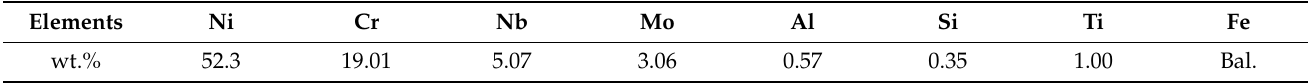
Table 1. Chemical composition of bonding metal IN718 alloy powder (wt.%). Figure 1. SEM images of powders. ( a ) Spherical IN718; ( b ) spherical WC. Elements